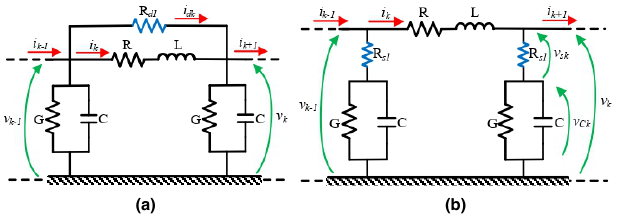
Figure 2. Modified topologies with: ( a ) R d 1 in the RL branch ( T 1 ) and ( b ) R s 1 in the CG branch ( T 2